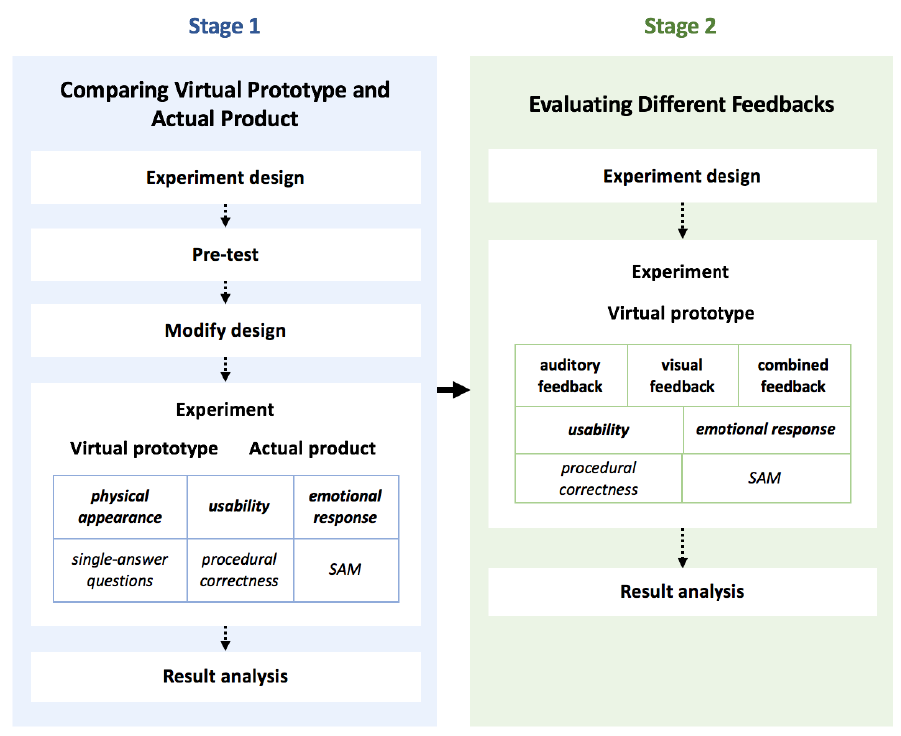
Figure 1. A two-stage experimental procedure proposed by this study.